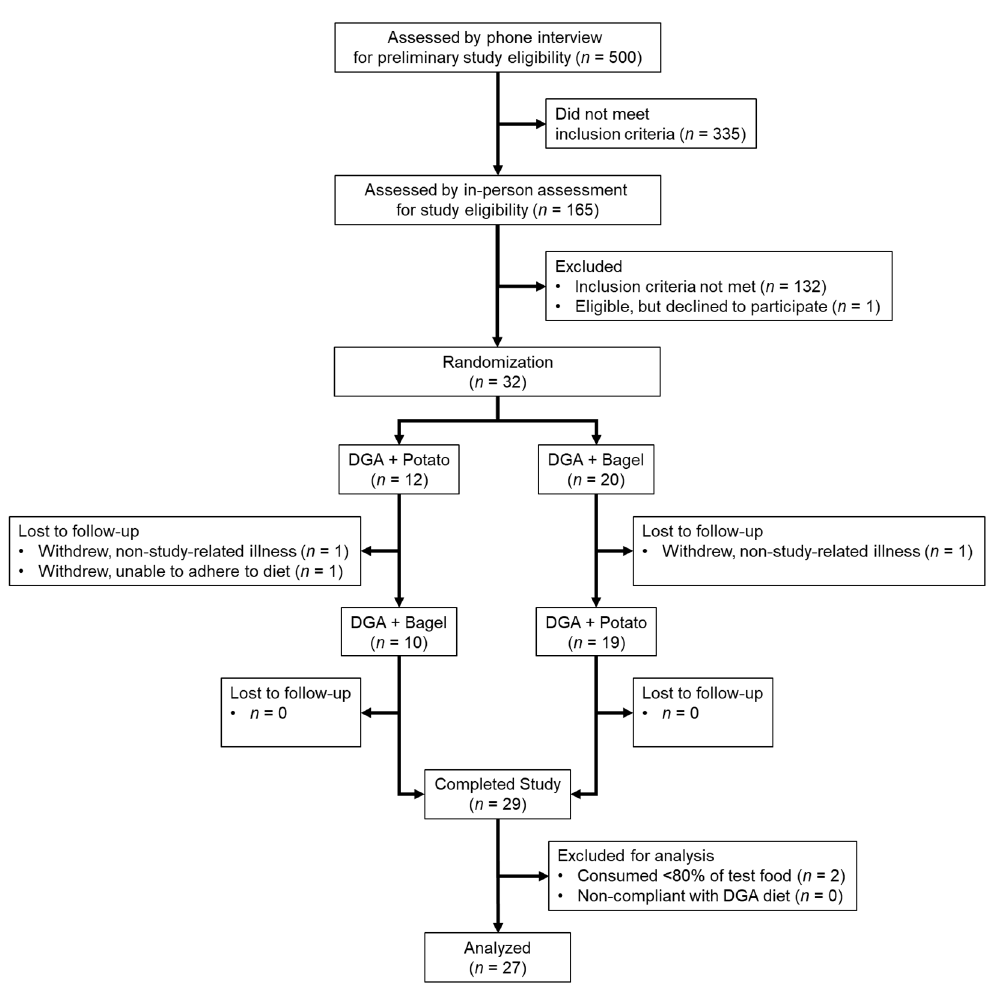
Figure 1. Enrollment and follow-up of study participants with MetS. Participants completed a randomized crossover study to examine daily potato (DGA + POTATO) or bagel (DGA + BAGEL)